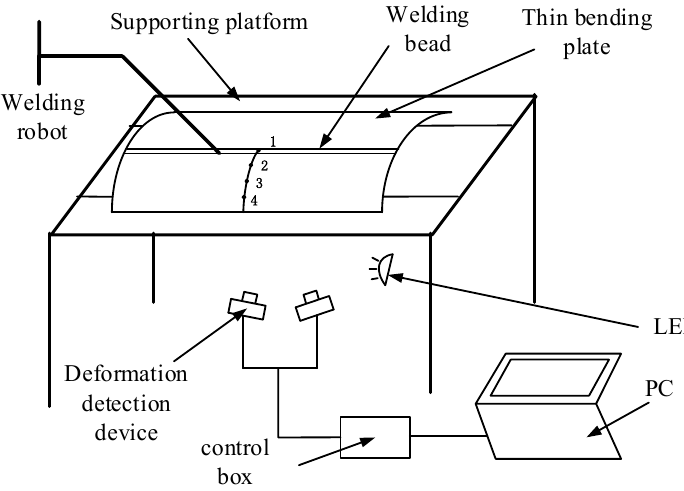
Figure 2. Welding and deformation detection in thin bending plates.